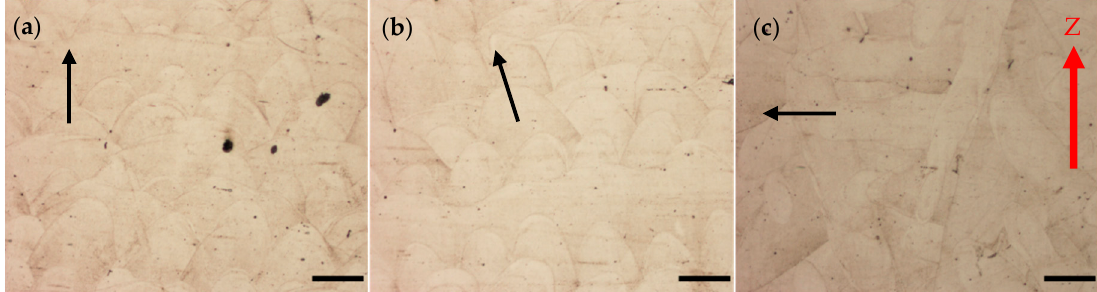
Figure 2. Optical images of as ‐ printed maraging steel samples printed in ( a ) V, ( b ) 45°, and ( c ) H orientations. The red arrow indicates the orientation of samples when imaged in the optical microscope. The scale is 10 μ m.